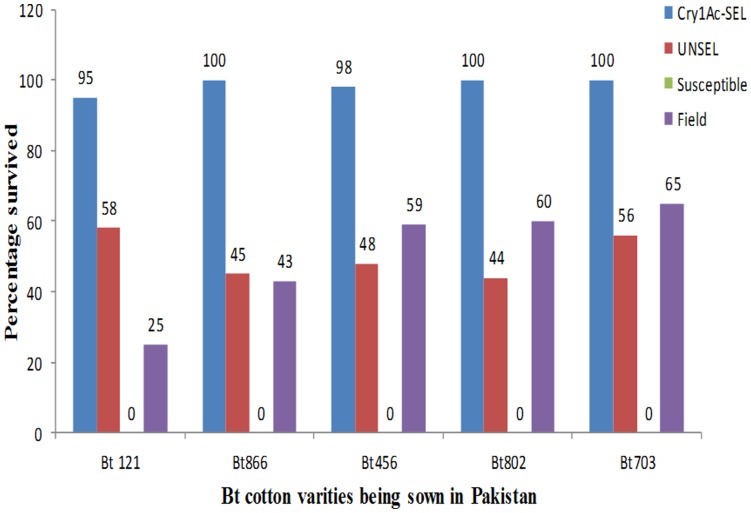
Survival of Cry1Ac-SEL, UNSEL and Lab-PK on different Bt cotton varieties being sown in different parts of Pakistan.